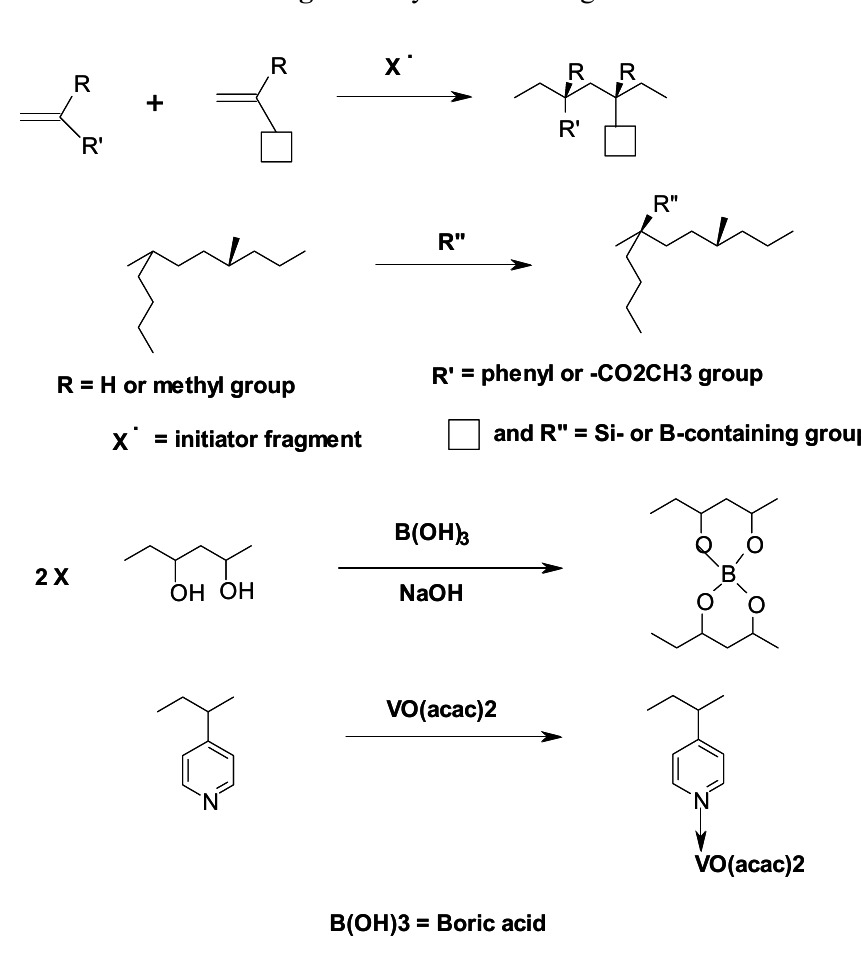
Figure 3. Synthetic